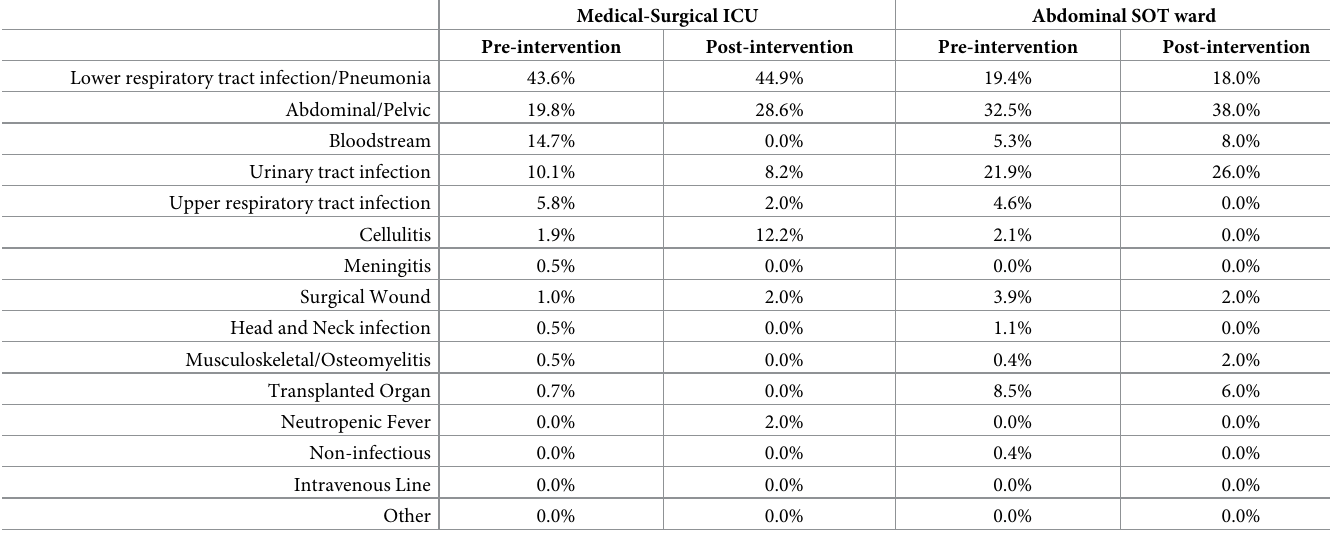
Table 4. Most common indications for fluoroquinolone use on pilot